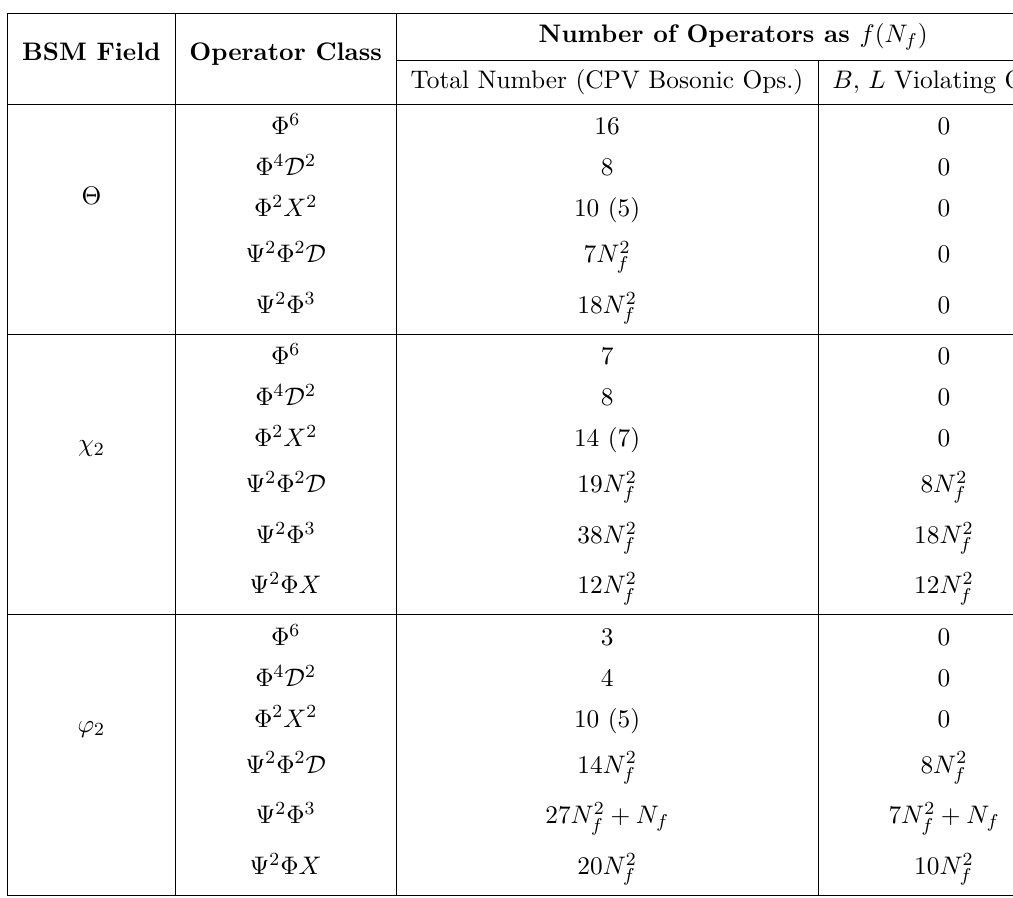
Table 42 . Number of additional operators of different classes at dimension 6 with N f fermion flavours, for models containing Θ , χ 2 and ϕ 2 . The numbers in parentheses denote the counting for CP violating purely bosonic